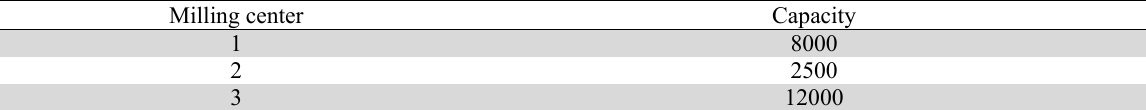
Capacity of milling centers (tonnes)